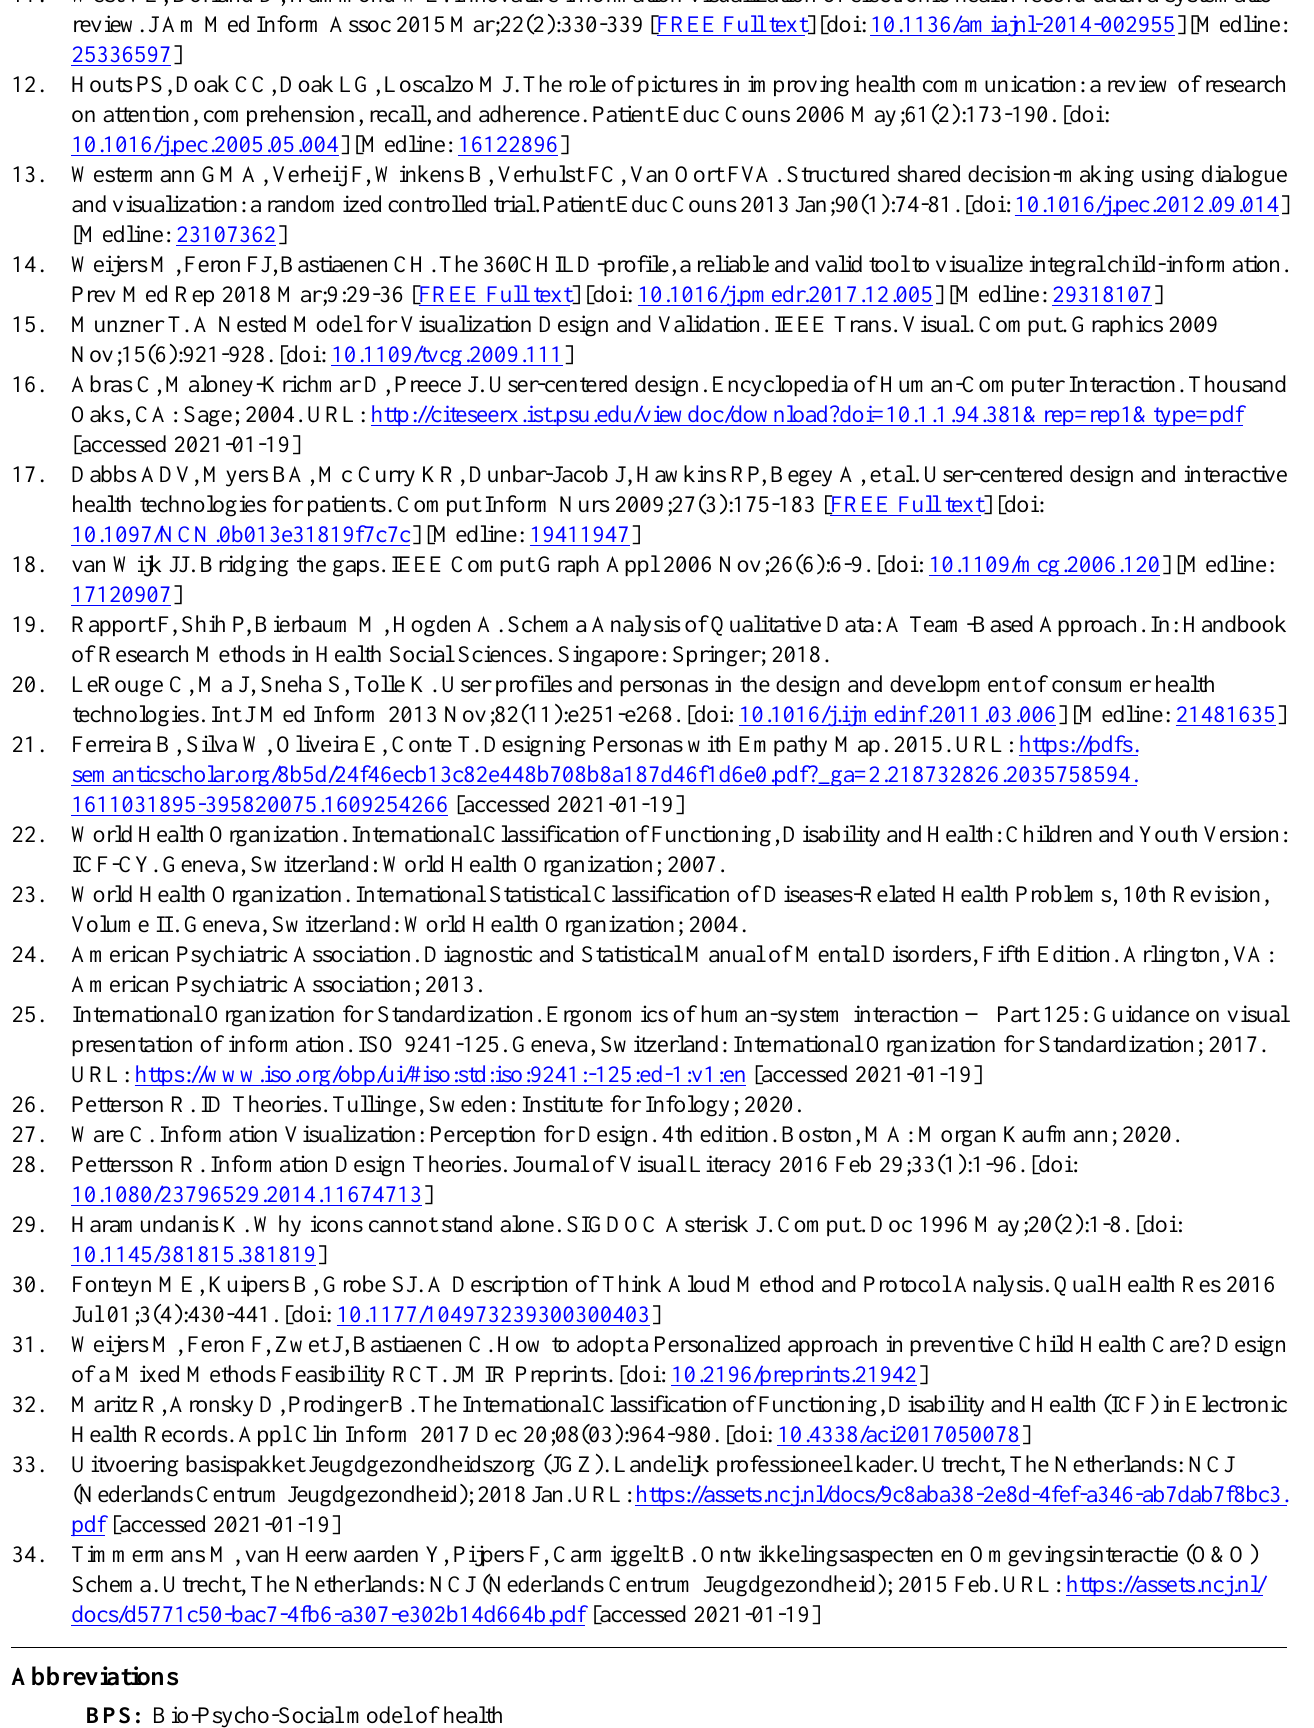
BPS: Bio-Psycho-Social model of